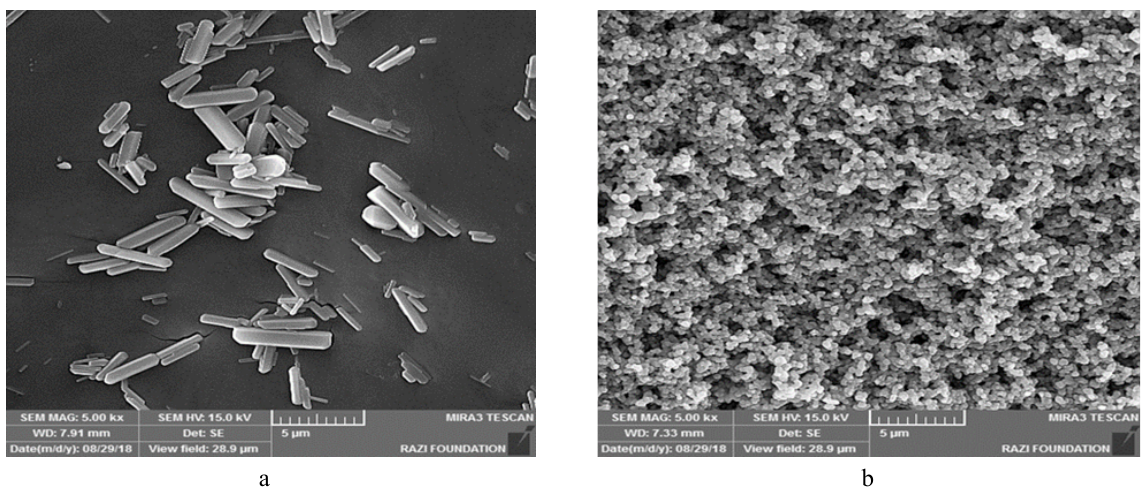
a b Figure 11. EDX of the ferrous sulfate before (a) and after (b) coagulation